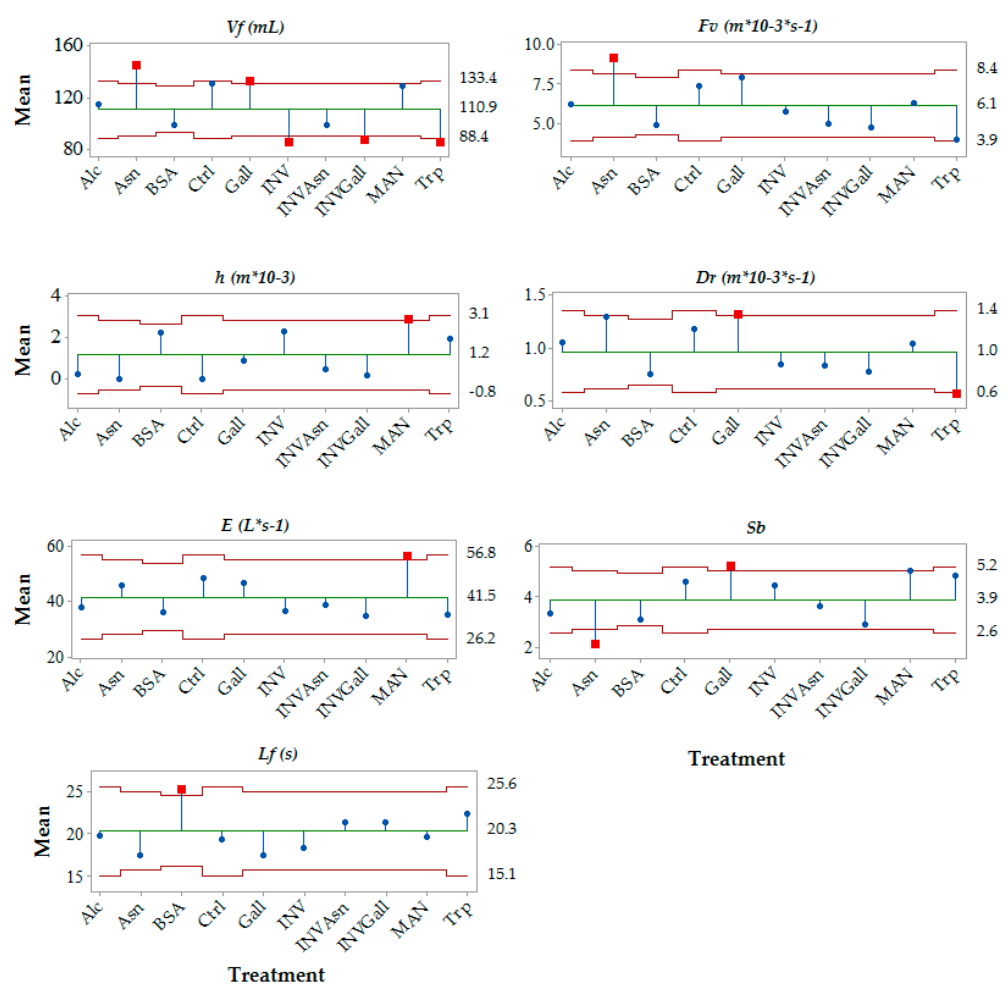
Figure 1. Foam parameters for wine treatments with added chemical compounds. The left and right ‘y’ axis, of each parameter, represents the values, in same units as found in the parentheses, next to each parameter. The average mean within a parameter, considering all samples, is represented by the green horizontal line; the mean value per sample is represented by the blue dot and when significantly different from the group means ( α = 0.05), the sample mean is highlighted as a small red square situated outside the limits. The red line represents the 95% interval limit. V f , foam volume; F v , foam velocity; h , collar height; D r , drainability; E , foam expansion; S b , small bubbles; L f , average foam lifetime.